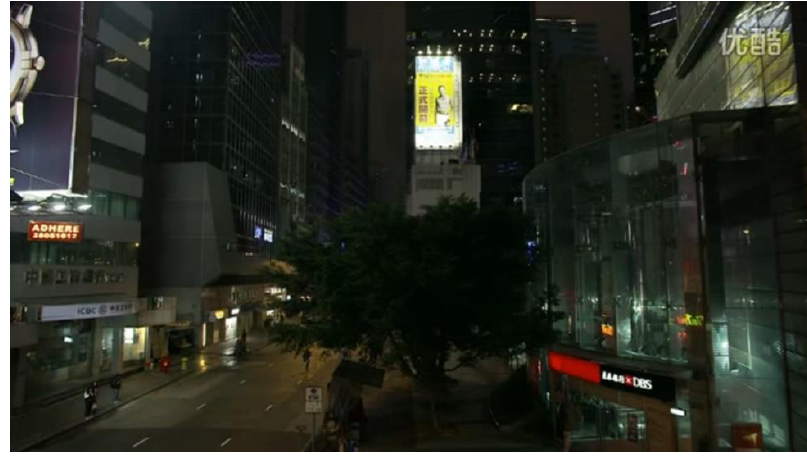
Figure 6. Where’s walker? A playful variation on Where’s Waldo?